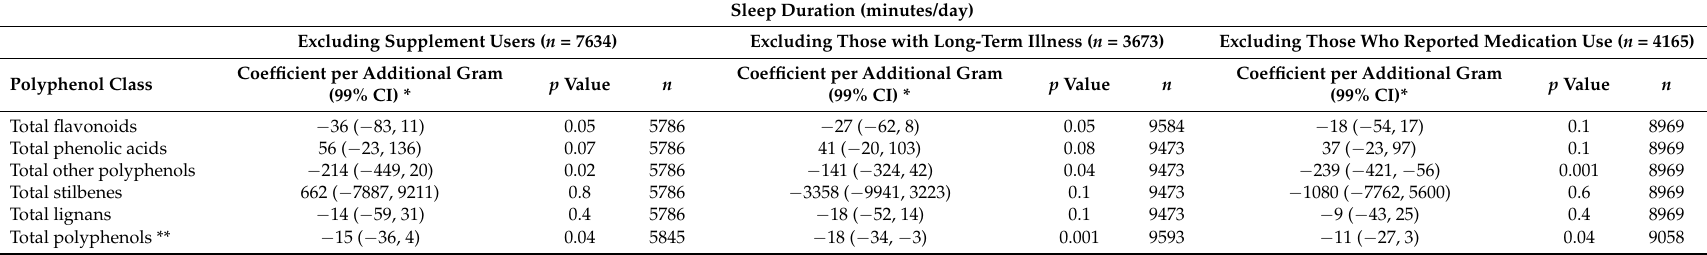
Table A6. Prospective associations between polyphenol content from fruit and vegetable intakes and sleep duration for women from the UKWCS after excluding participants who self-reported supplement intake, long-term illness and medication